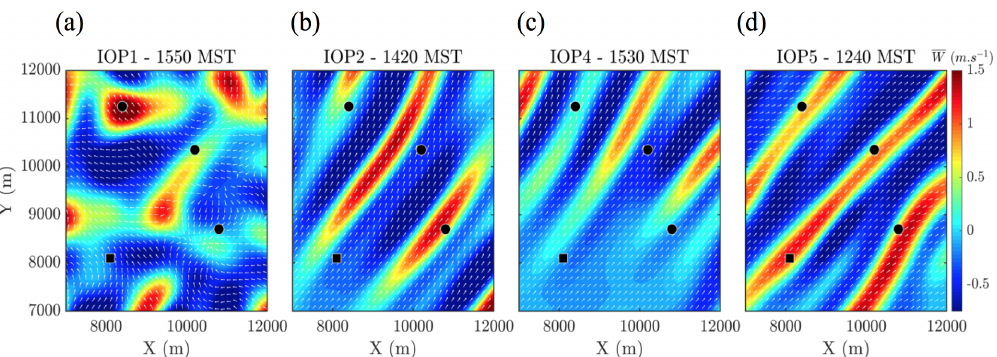
Figure 13. The 10-min averaged vertical velocity contours at 0.5 z i during (from left): ( a ) IOP1; ( b ) IOP2; ( c ) IOP4; and ( d ) IOP5. Normalized wind vectors show the 10-min averaged wind direction across the PSB1 site. Start time for the 10-min average period is given on top of each sub-figure. Black square represents the tracer release location during PSB1 and the black circles represent the sonic anemometers on the 3200-m arc radius from release